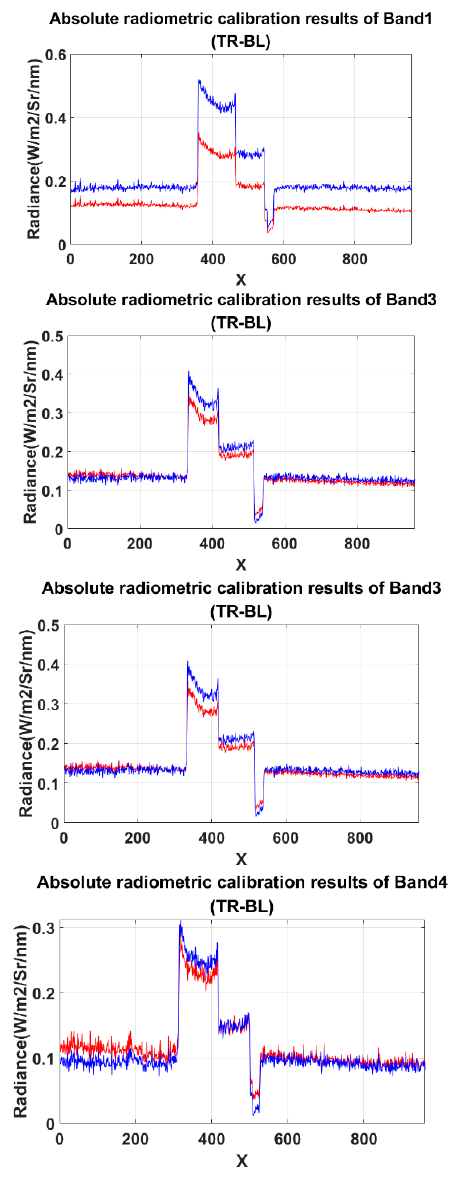
( b ) Figure 24. Diagonal radiance value of the spectral images calibrated by the LUT method (blue) and manufacturer’s method (red): ( a ) radiance value of BR-TL diagonal in five bands; ( b ) radiance value of TR-BL diagonal in five bands. 4. Discussion The radiometric calibration process of remote sensing instruments involves many aspects and is complex, especially for 2D image sensors. According to the comparison with the method provided